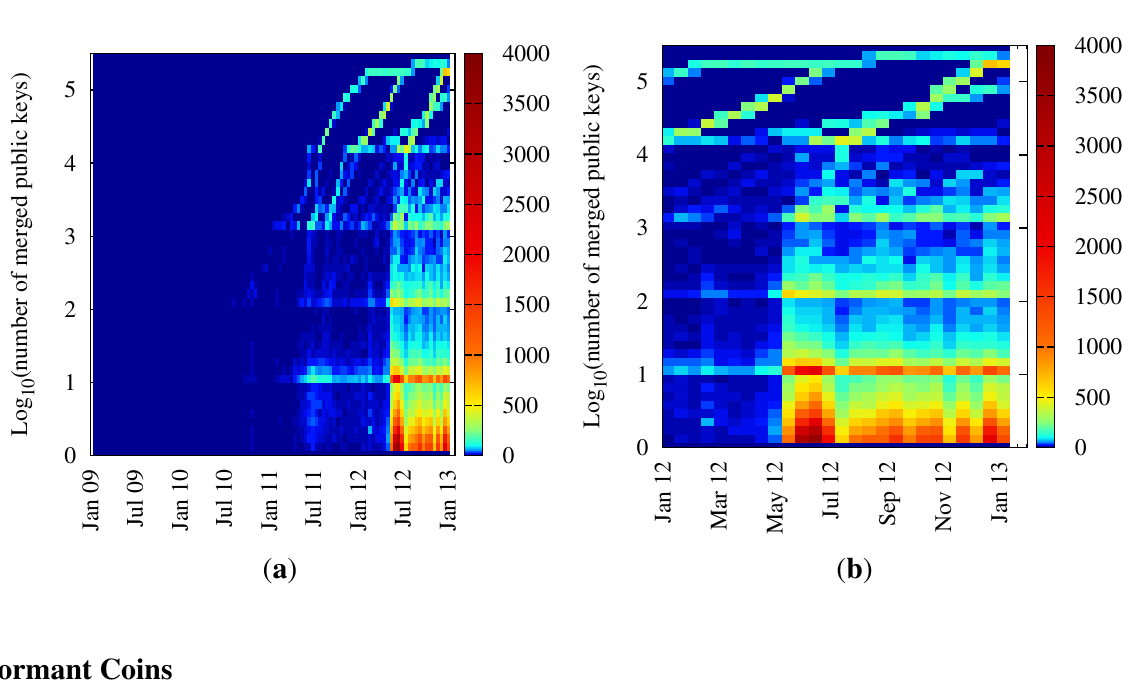
Figure 9. Histogram on the number of entity merging events depending on date and the total number of merged public keys. The data is binned both in time (100 steps) and merging size ( 1 , 2 , 3 , . . . , 10 , 20 , . . . , 100 , . . . ). ( a ) Histogram of merging events over time; ( b ) Histogram of merging events over time (zoomed in to last